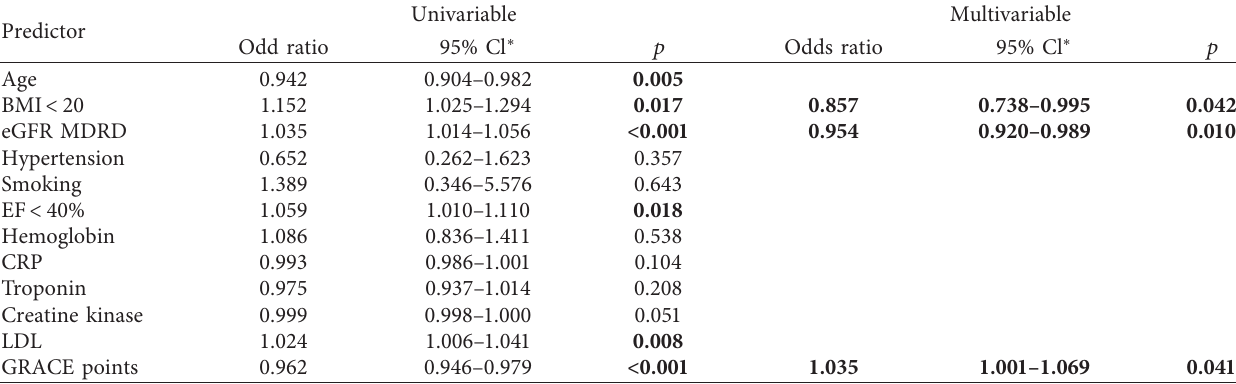
Table 3: Univariable and multivariable regression analysis of risk factors of death in Takotsubo ( n � 101). Univariable Predictor